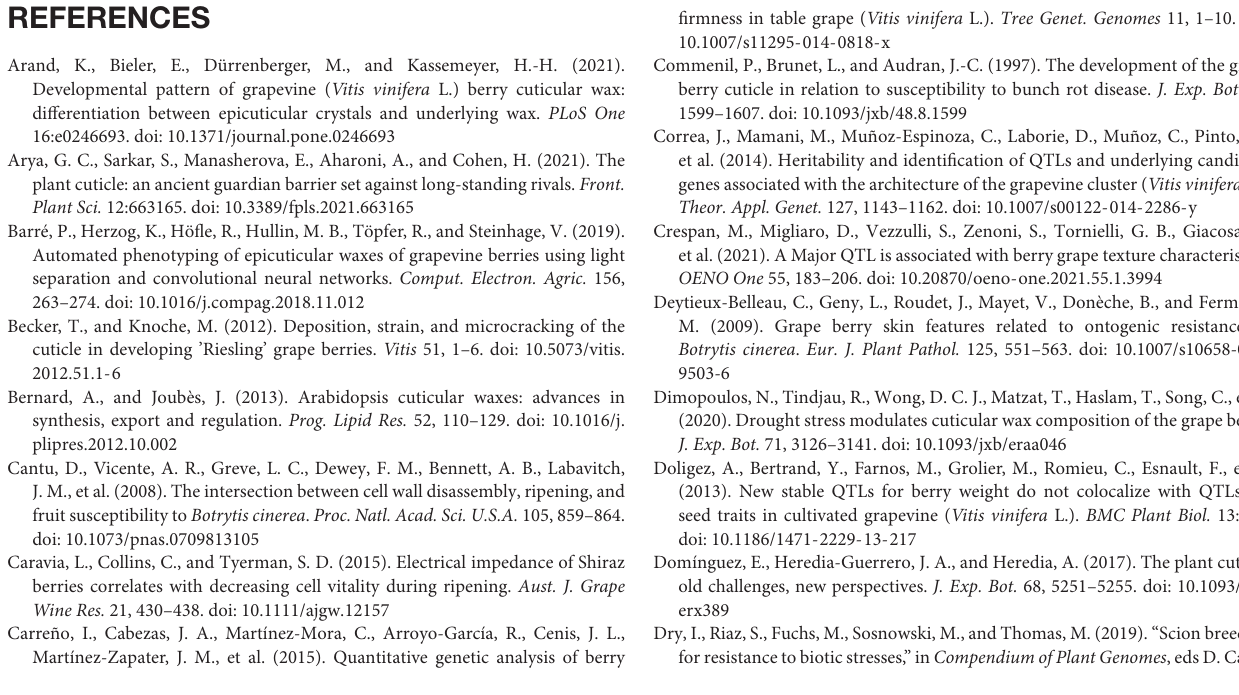
Supplementary Figure 1 | Ultrastructure of epicuticular wax on the berry surfaces of ‘Riesling’: ‘Calaris Blanc,’ and ‘Norton’ in two independent years of 2018 and 2019 in comparable maturity stage of grapes. Supplementary Figure 2 | Correlation plot of investigated phenotypic traits within the segregating mapping population ‘Dakapo’ × ‘Cabernet Sauvignon’ (D × C) at harvest. The sensor-based phenotypes of mean berry diameter (MBD) as well as physical berry skin characteristics Z REL . TA FORCE , TA GRAD , and TA AREA were considered for QTL analysis. MS CT and MS BST were used as ground truth for berry skin thickness. N = 180. MBD, mean berry diameter; Z REL , relative impedance; TA FORCE , berry skin firmness; TA GRAD , berry firmness; TA AREA , berry skin elasticity; MS CT , microscopic cuticle thickness; MS BST , microscopic berry skin thickness. Supplementary Figure 3 | (A–E) Boxplot of the berry impedance Z REL , berry texture traits, and MBD of the mapping population D × C in relation to the expression of the Teinturier phenotype. Different letters indicate significant differences based on Tukey HSD group comparison of means. Green dots display the mean values. N = 362. TA, texture analysis; TA FORCE , berry skin firmness;